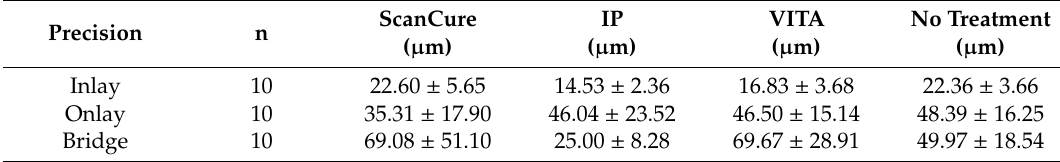
Table 3. Mean precision value according to an intraoral scanner (mean ± SD of RMS) Precision